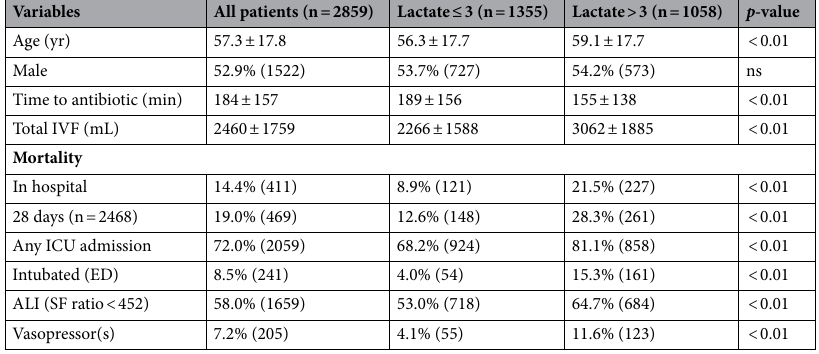
Table 2. Patient Demographics and clinical characteristics stratified by lactate level.